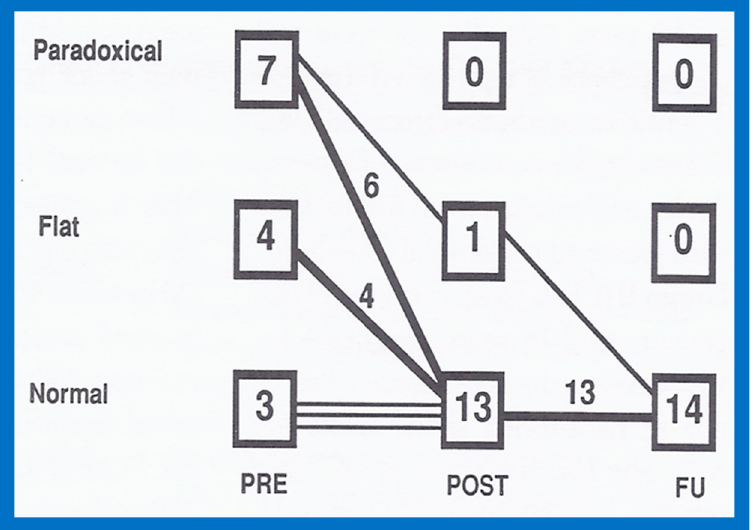
Figure 37. Changes in the inter-ventricular septal motion following percutaneous occlusion of atrial defects are demonstrated in the above graph. Before atrial septal defect (ASD) occlusion (PRE), the inter-ventricular septal motion is either flat or paradoxical in most subjects. Shortly following atrial defect closure (POST), the inter-ventricular septal motion has normalized in all except a single patient. During follow-up (FU), the inter-ventricular septal motion is normal in the entire patient cohort. Reproduced from Reference [60].